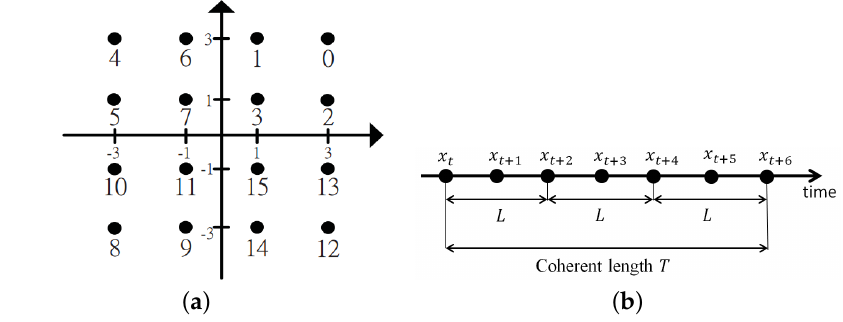
Figure 1. Conventional 16-QAM constellation and illustration of block fading. ( a ) 16-QAM constellation; ( b ) an illustration of block fading length T = 7 and signal vector length L =